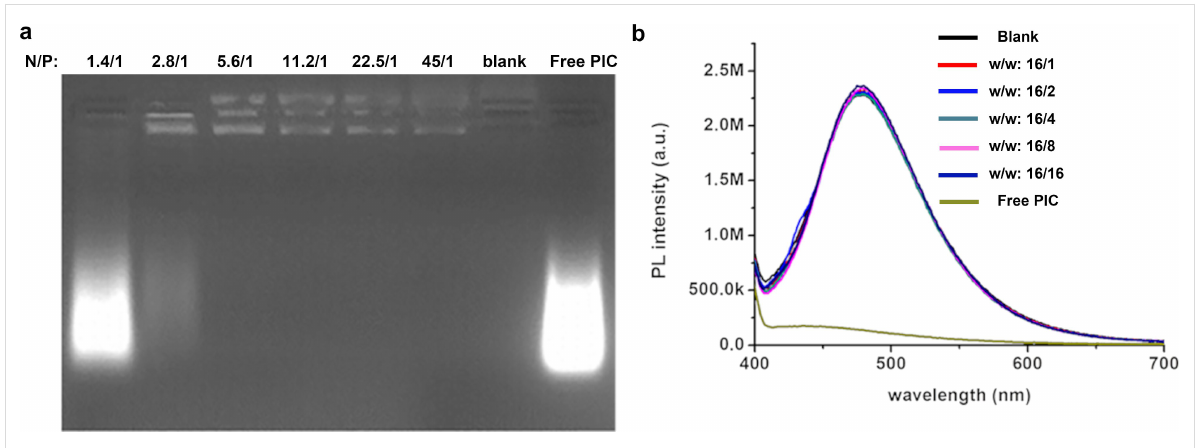
Figure 2: a) Gel electrophoresis showing the binding of PIC to SPION@bPEI (the PIC amount was kept constant at 4 µg/well) at different N/P ratios. b) PL spectra of free PIC, SPION@bPEI, and SPION@bPEI/PIC (1.28 mg/mL constant nanoparticle concentration) at different SPION@bPEI to PIC w/w ratios. λ exc = 355